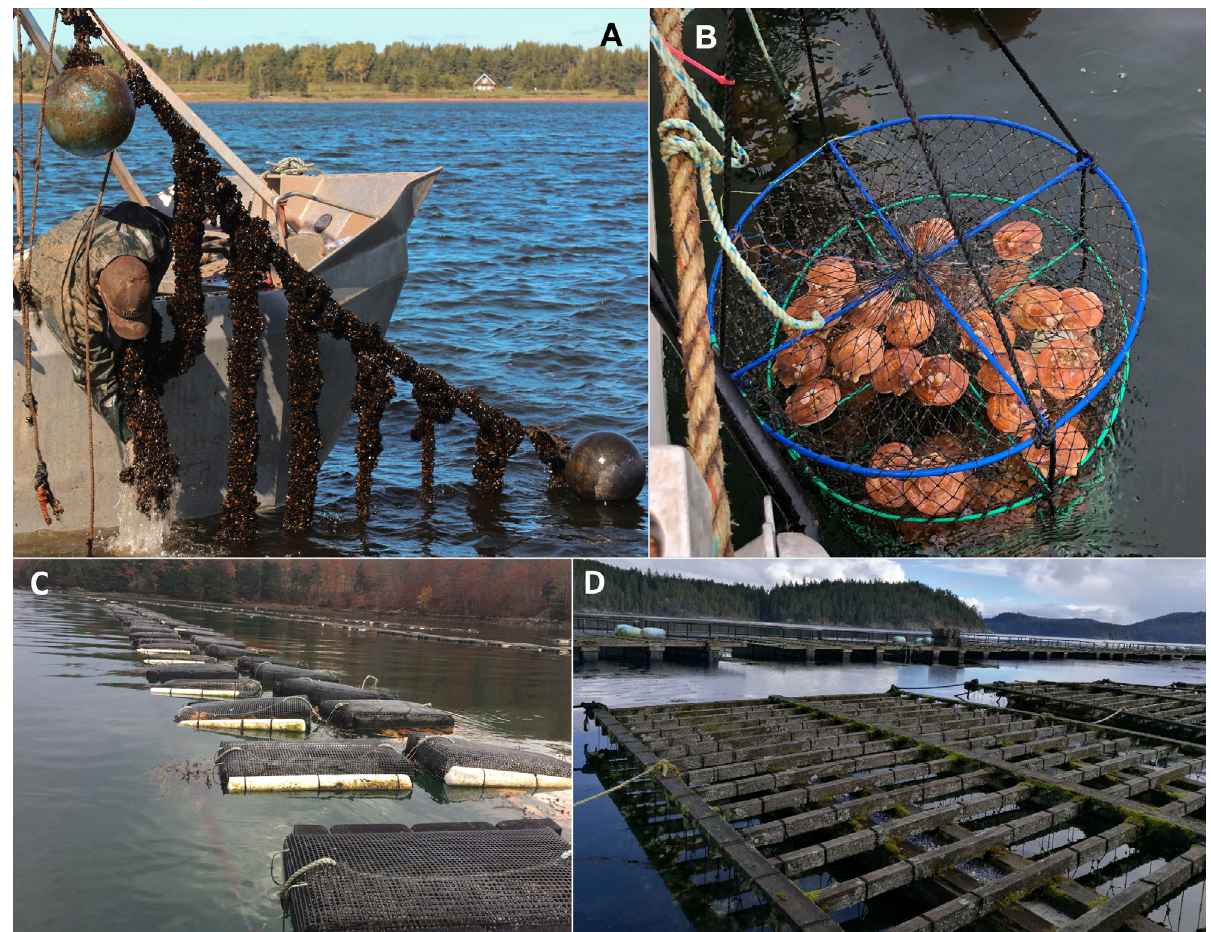
Fig. 3. Examples of sub-tidal off-bottom culture. (A) Suspended longline mussel farm (photo: Aaron Ramsay). (B) Suspended longline scallop farm (photo: Dana Morse). (C) Suspended oyster cage farm (photo: Oyster Gro). (D) Suspended raft oyster farm (photo: British Columbia Shellfish Growers